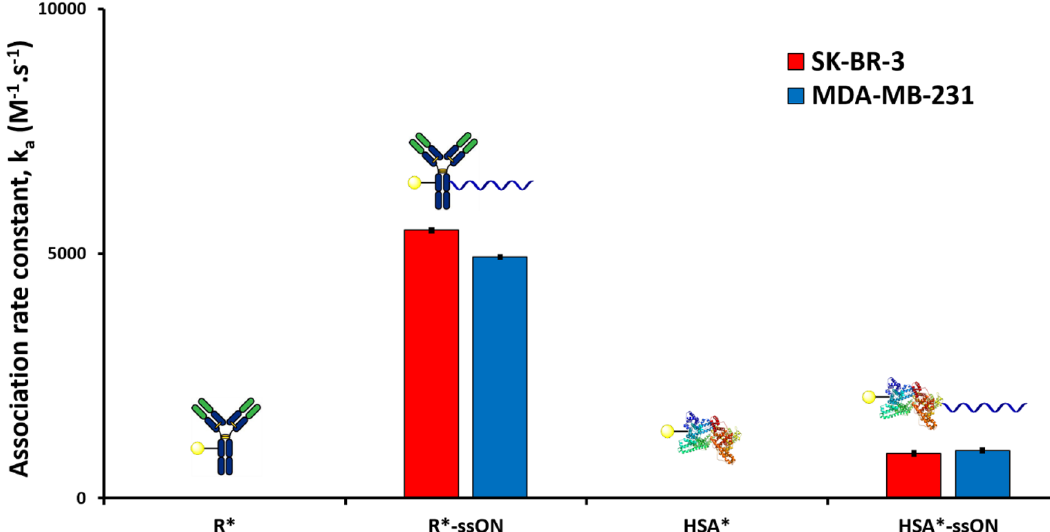
Figure 3. Association rate constants (k a ) of unconjugated rituximab (R*), single stranded rituximab-ssON conjugate (R*-ssON), unconjugated HSA (HSA*), and single stranded HSA-ssON conjugate (HSA*-ssON) on SK-BR-3 (HER2 + cell line, red bars) and MDA-MB-231 (HER2 − cell line, blue bars) measured using the time- resolved analysis of ligand binding assay (Fig. S7-10). The symbol * indicates fluorescein-labelling. Error bars indicate the standard error of the fitted parameter k a